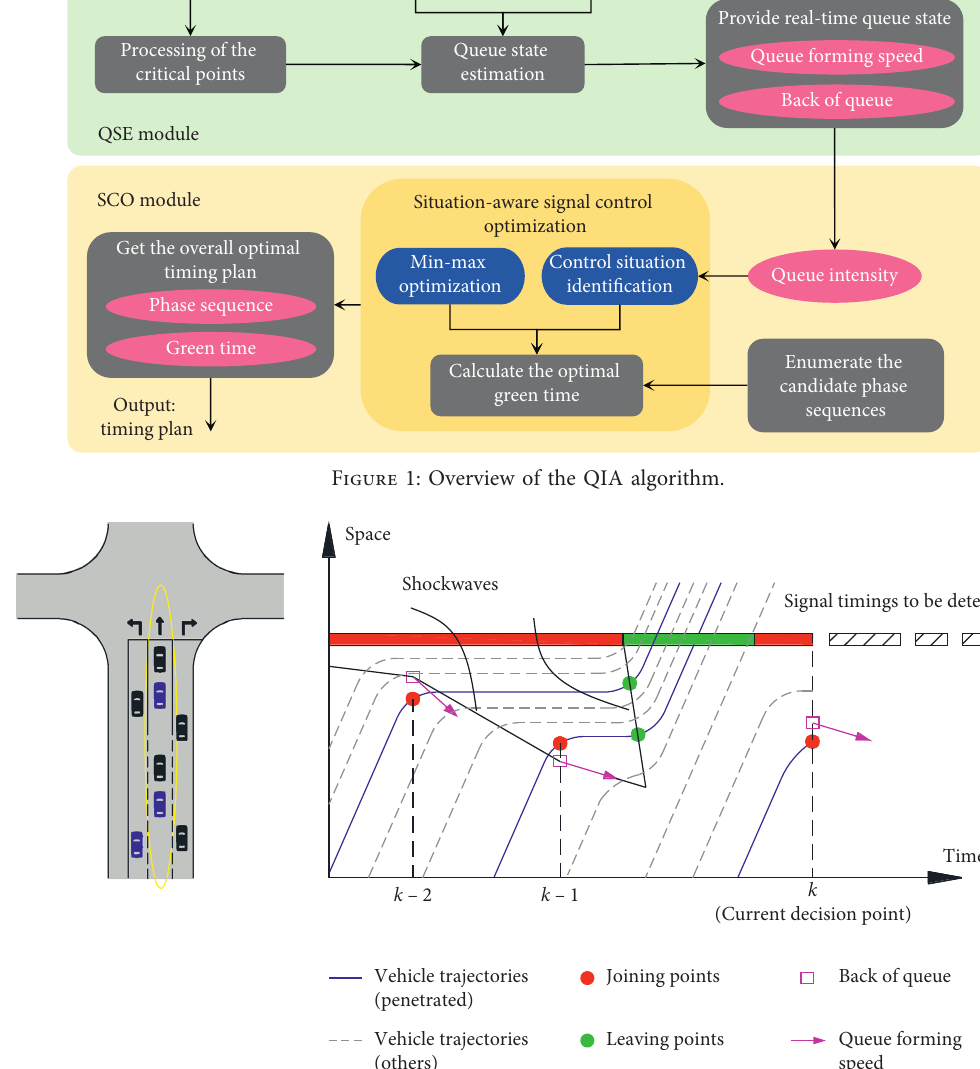
Figure 2: Illustrations for basic ideas of the QSE